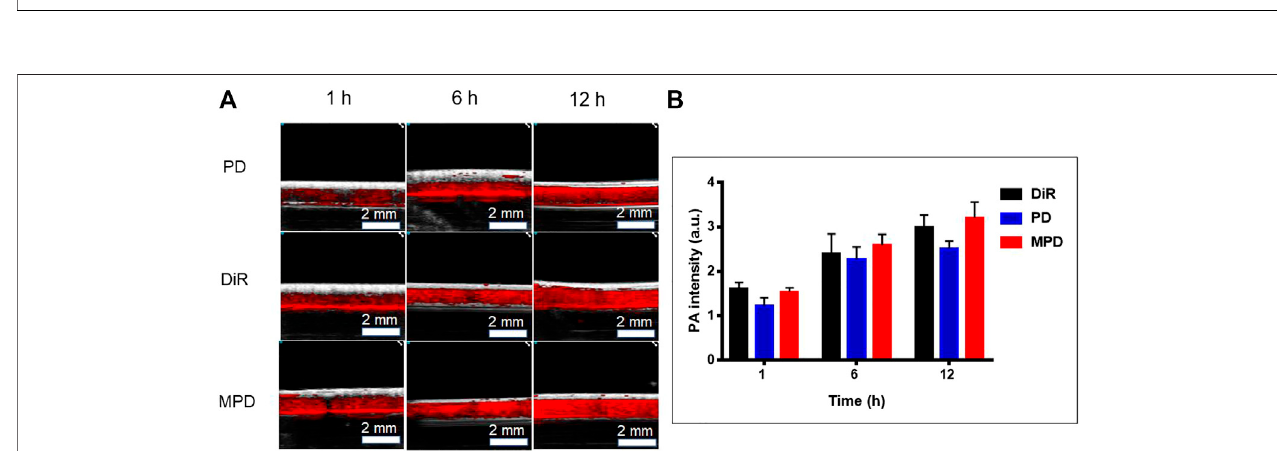
FIGURE 3 | In vitro photoacoustic imaging analysis. (A) PA image of DiR-based nanoparticles at different time points. (B) Quantitative analysis of DiR-based nanoparticlesatdifferenttimepoints( n (cid:1) 3).LLCcellswereseededtothecellculturedisheswithadensityof5 × 10 5 cells/dishfor24 h.Afterincubationfor1,6,and12 h withfreeDiRornanocompositematerials (PDand MPD)containingthesame amountofDiR,respectively,thecellswerecollectedand fi xedwithparaformaldehyde.The cell suspension was put into the imaging capillary tube and sealed at both ends with a lighter. The LAZR-X multimode imaging system was used to detect the PA signals. The Vevo LAB 3.2.0 software was applied to analyze data and fl uorescence intensity.